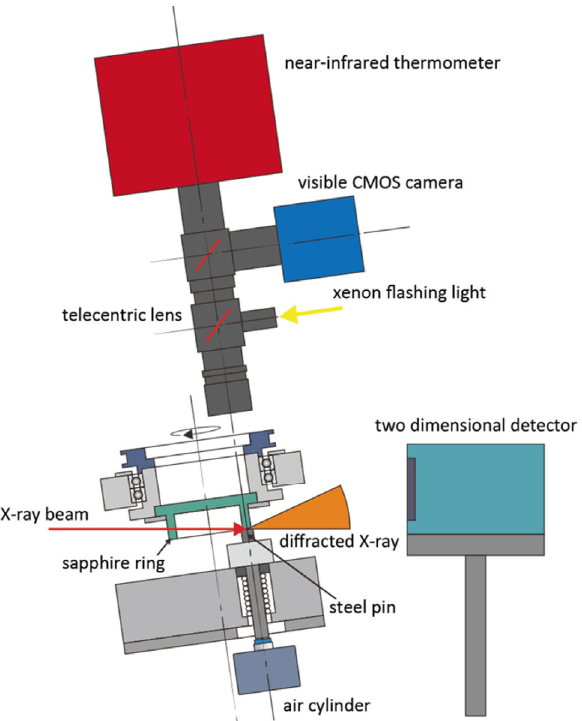
Fig. 25 A multidimensional in-situ observation system [256]. Reproduced with permission from Ref. [256], © Springer Science+Business Media, LLC, part of Springer Nature,